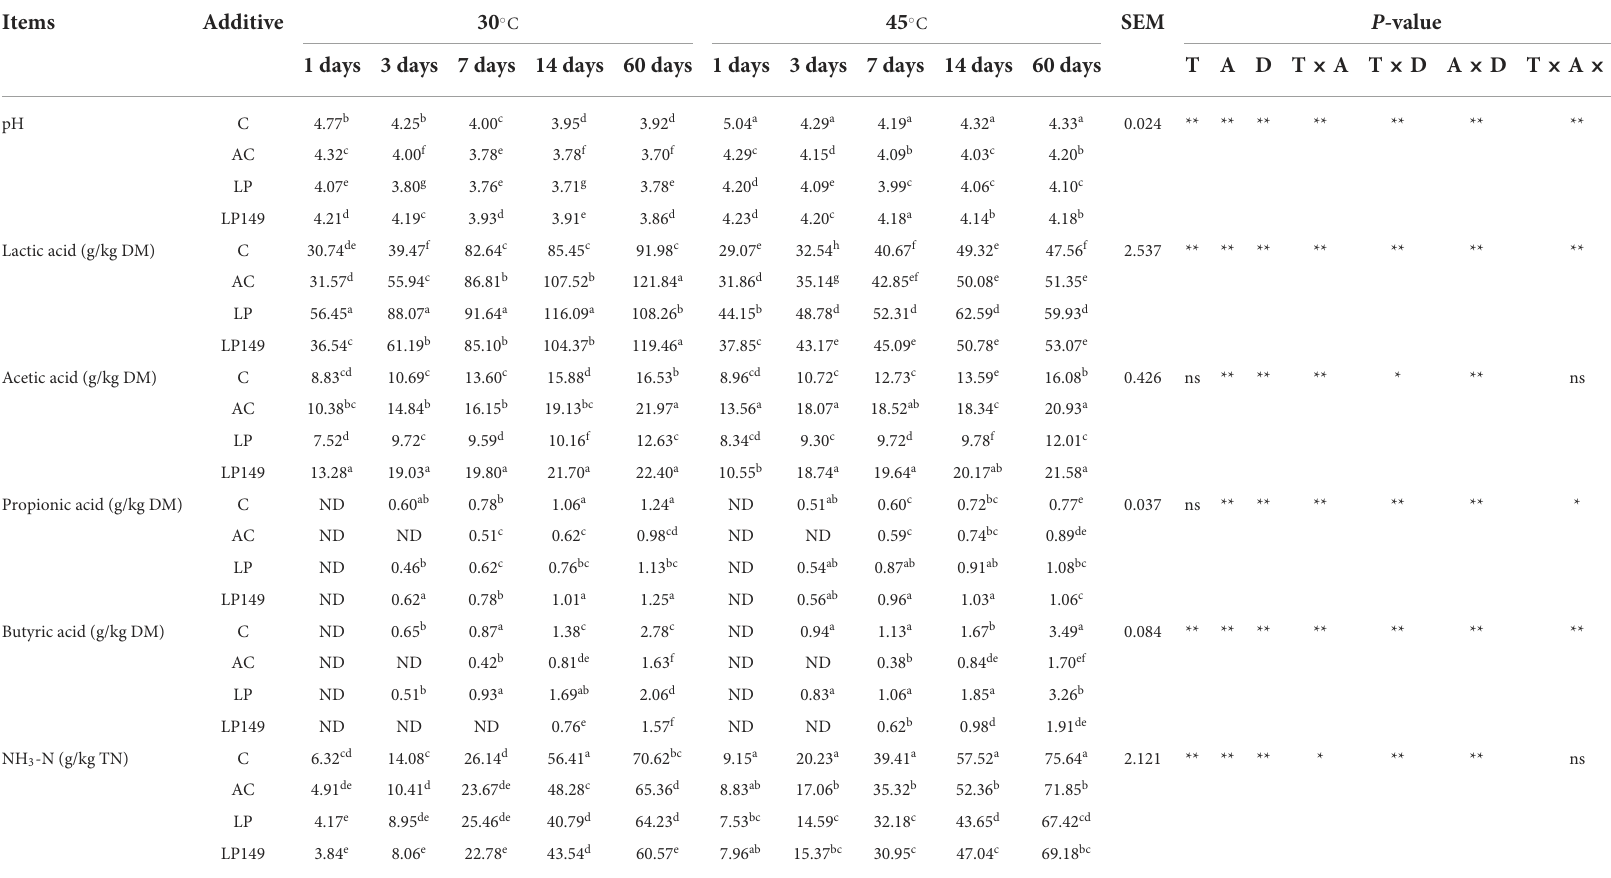
TABLE 1 Fermentation characteristics of hybrid elephant grass silages treated with additives at different ensiling times and temperatures. Items